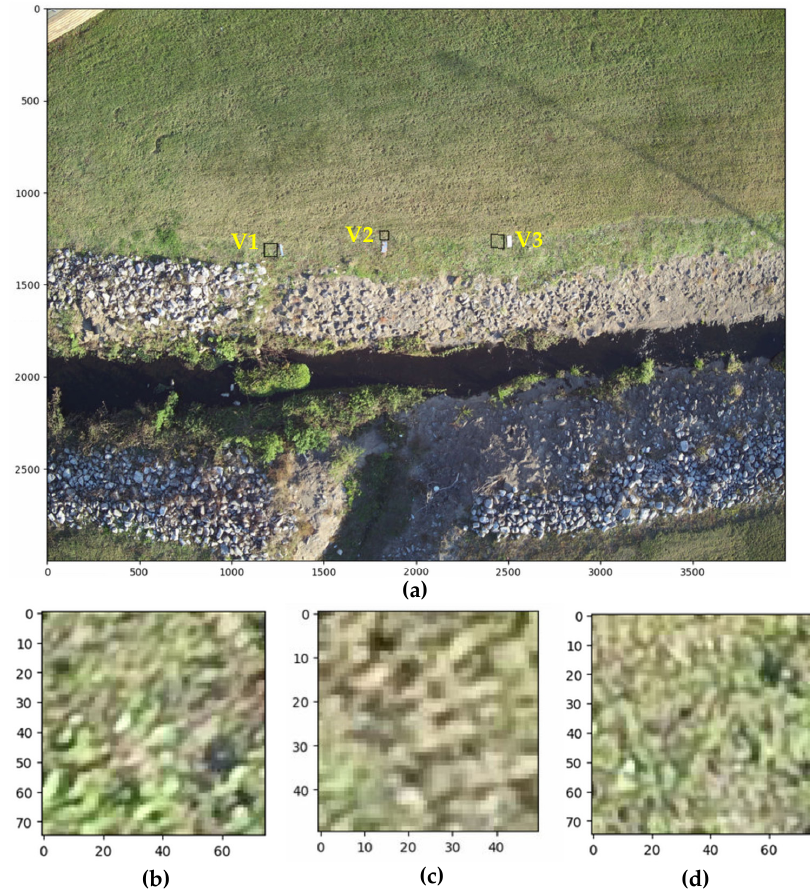
Figure 18. University slope. ( a ) UAV RGB image at 100 ft. altitude. ( b ) Region of interest V1. Figure 18 . University slope. (a) UAV RGB image at 100 ft. altitude. (b) Region of interest V1. (c) ( c ) Region of interest V2. ( d ) Region of interest V3. Region of interest V2. (d) Region of interest V3.